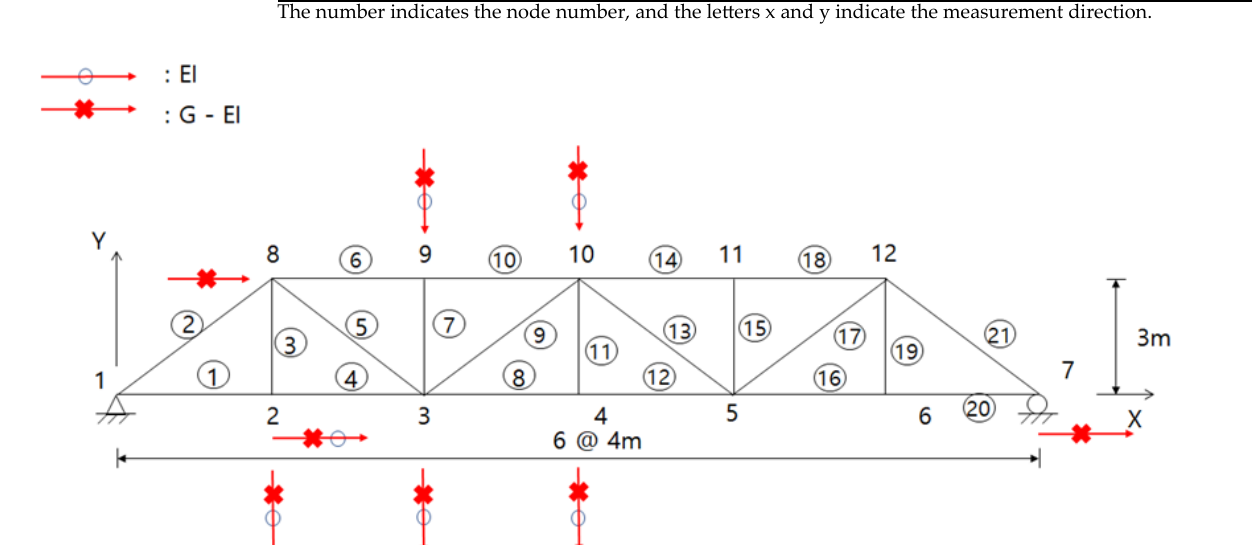
Figure 3. Final displacement sensor locations using both methods.